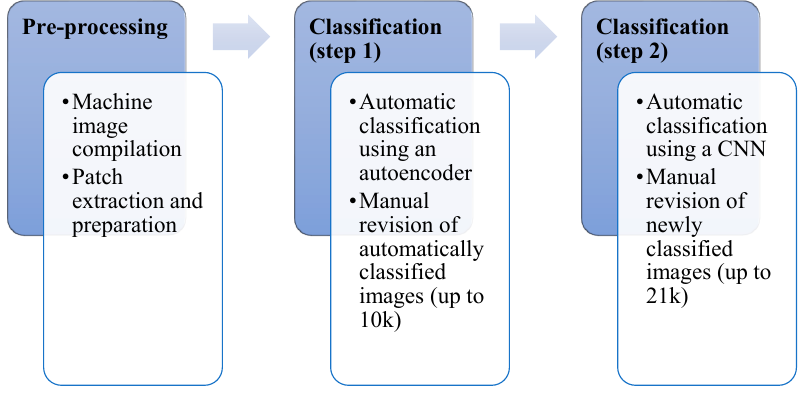
Figure 2. Outline of the dataset preparation and revision process.